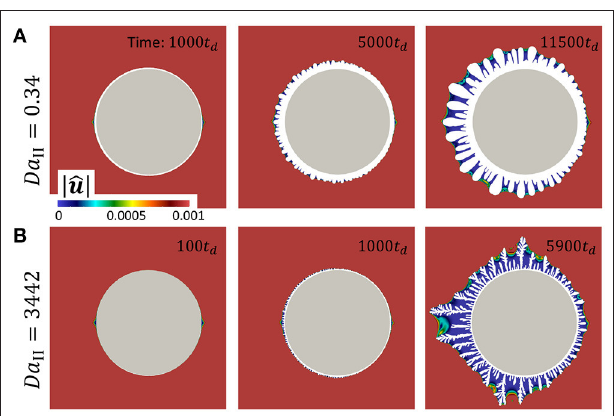
FIGURE 7 | Flow velocity map and precipitate shape which correspond to the data in Figure 6 . (A) Da II = 0.34. (B) Da II = 0.34. The color map is scaled to | ˆ uuu | max = 0.001. The snapshots were taken at the simulation times which correspond to the data in Figure 6 .